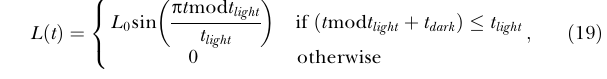
( i , j ) denotes a directional coupling from cell j to cell i ( C i,j ¼ 1), and a blank space means that there is no coupling ( C i,j ¼ 0). (A) Matrix C for the random coupling type (type 1). (B) Matrix C for the nearest-neighbor coupling type (type 2). The matrix is symmetrical; hence, all coupling is bidirectional. (C) Matrix C for the SCN coupling type (type 3). The red and blue shades represent DM intercellular coupling, and the black dots represent projections from the VL to the DM regions. Found at doi:10.1371/journal.pcbi.0030068.sg001 (148 KB PDF). Figure S2. Raster Plot of 625 Oscillators with Nearest-Neighbor (Type 2) Coupling in a 3-D SCN Geometry SCN geometry is organized according to their regions (from bottom up, VLL: left VL region, VLR: right VL region, DML: left DM region, DMR: right DM region, and Int: intersection between left and right DM regions). The concentration of Per/Cry mRNA for each oscillators is represented by colors (blue, low concentration; red, high concen- tration). All other parameters are as in Figure 3A and 3B. Found at doi:10.1371/journal.pcbi.0030068.sg002 (1.9 MB PDF). Figure S3. Synchronization of Ten All-to-All Coupled Oscillators with Noisy Coupling and Noisy Intrinsic Periods We used a multiplicative noise described by stationary Gaussian process (Ornstein-Uhlenbeck process; see Text S1) with noise strength S . (A,B) Synchronization-coupled oscillators with noisy transmitter release and noisy intrinsic periods ( S ¼ 0.03, K ¼ 0.9). Simulations were made over 2,400 h ([A]; gray lines, individual oscillators; blue line, average of the ten oscillators). Synchronization was good ( R ¼ 0.89) despite the variations in amplitudes and periods (B). (C) Coupling improves temporal precision. Successive periods of the average output of synchronized oscillators (black bars, label P) show a better precision than individual oscillators in the synchronized state (gray bars, label C) and uncoupled oscillators (white bars, label U). The standard deviations were 0.5 h, 0.6 h, and 1.9 h, respectively, for data from simulations shown in (A) and (B). (D) Effect of noise strength S on the order parameter R and the standard deviation of periods of the average output of coupled oscillators. Synchronization was good ( R . 0.8; blue lines) and standard deviation limited ( , 2 h; red dashed lines) for S below 0.05. For S larger than 0.05, synchronization was still achieved, but the period became unreliable. (E,F) Global noise can enhance synchrony. In the presence of strong noise ( S ¼ 0.2), weakly coupled oscillators ( K ¼ 0.4) maintained rhythmicity and synchrony ( R ¼ 0.94) (E). For weaker noise ( S ¼ 0.05), the same weakly coupled oscillators did not maintain rhythmicity (F). Found at doi:10.1371/journal.pcbi.0030068.sg003 (273 KB PDF). Figure S4. Synchronization of 309 Goodwin-Type Damped Oscillators with Nearest-Neighbor (Type 2) Coupling The simulation is divided in four parts to show synchrony, damping, restoration of synchrony, and damping under constant signal. First, in constant darkness (DD) with normal coupling ( K ¼ 1.5), oscillators are well-synchronized. Second, in DD without coupling ( K ¼ 0), oscillators lose synchrony and rhythmicity. Third, in DD, normal coupling ( K ¼ 1.5) restores synchrony and rhythmicity. Fourth, in constant light (LL) without coupling, oscillators lose rhythmicity, showing that they are damped in the absence of a variable signal. Found at doi:10.1371/journal.pcbi.0030068.sg004 (20 KB PDF). Figure S5. Synchronization of 100 One-Variable Negative Feedback Loop Oscillators with Delay (All-to-All Coupling) The simulation is divided into four parts to show synchrony, damping, restoration of synchrony, and damping under constant signal. First, in DD with normal coupling ( K ¼ 0.1), oscillators are well- synchronized. Second, in DD without coupling ( K ¼ 0), oscillators lose synchrony and rhythmicity. Third, in DD, normal coupling ( K ¼ 0.1) restores synchrony and rhythmicity. Fourth, in LL without coupling, oscillators lose rhythmicity, showing that they are damped in the absence of a variable signal. Found at doi:10.1371/journal.pcbi.0030068.sg005 (21 KB PDF). Figure S6. Synchronization of 40 Leloup-Goldbeter Oscillators with All-to-All Coupling The simulation is divided into four parts to show synchrony, damping, restoration of synchrony, and damping under constant signal. First, in DD with normal coupling ( K ¼ 1), oscillators are well- synchronized. Second, in DD with weak coupling ( K ¼ 0.6),